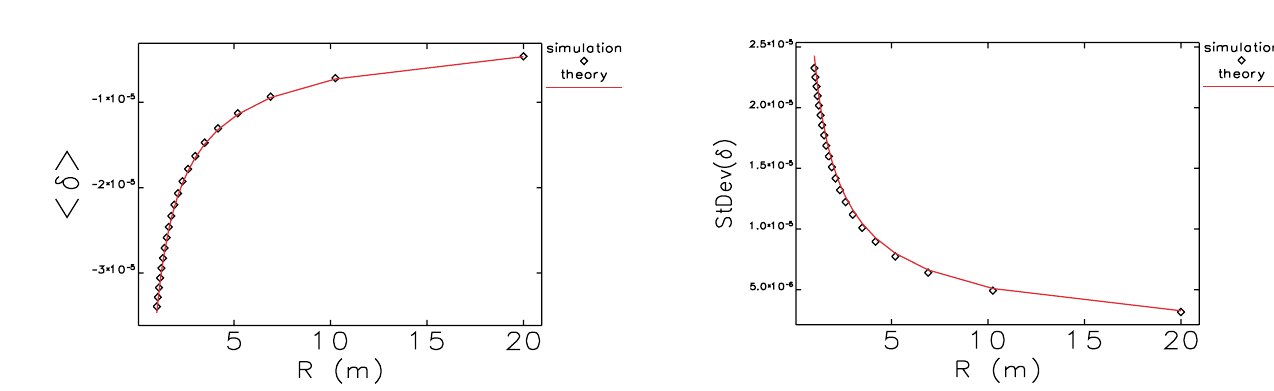
FIG. 3. (Color) Standard deviation of fractional momentum offset vs bending magnet